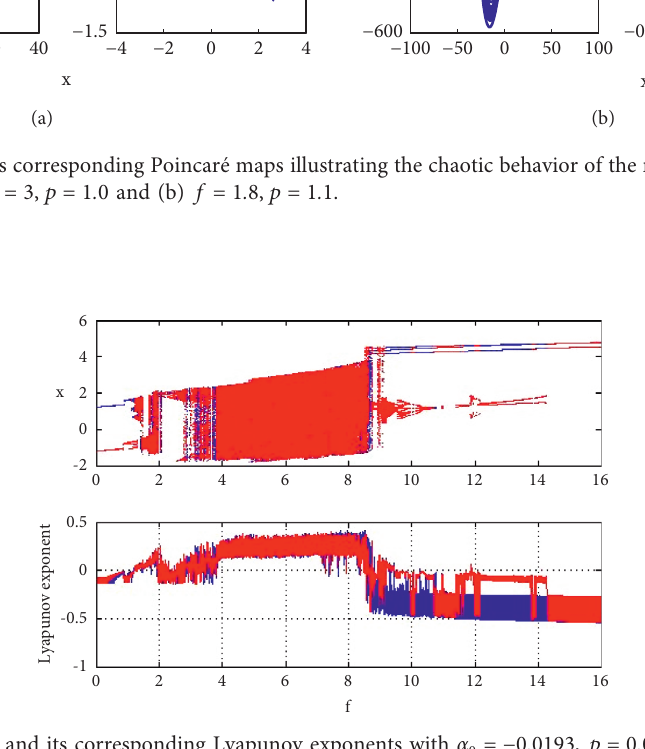
� − 0 . 0193, p � 0 . 005, ω � 1, and Ω � 3. The other 0